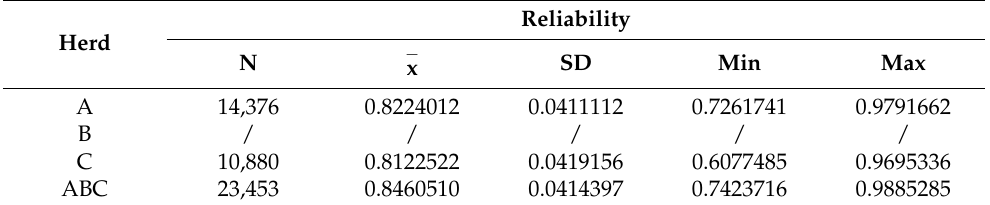
Table 7. Average reliability of prediction in contemporary groups using purebred and crossbreed data.